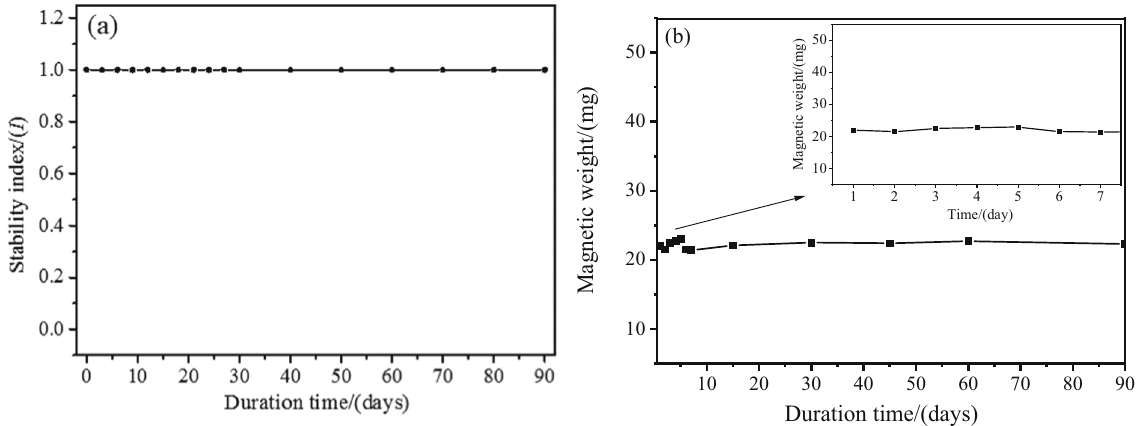
Figure 4: Stability characterization of Fe 3 O 4 @DDT - PMAA MFs, ( a ) stability index versus duration time and ( b ) relationship between time and increased magnetic weight in magnetic fi eld of 40